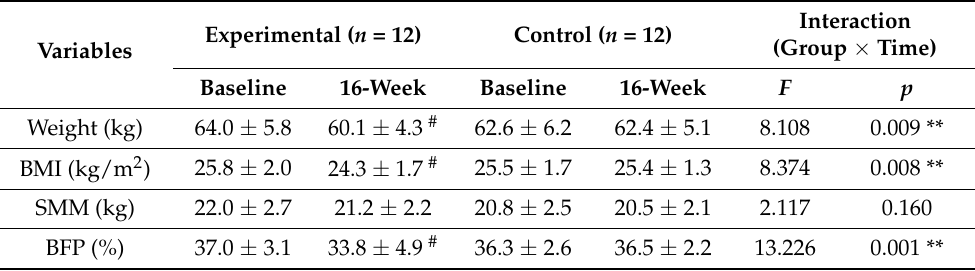
Table 2. Changes in body